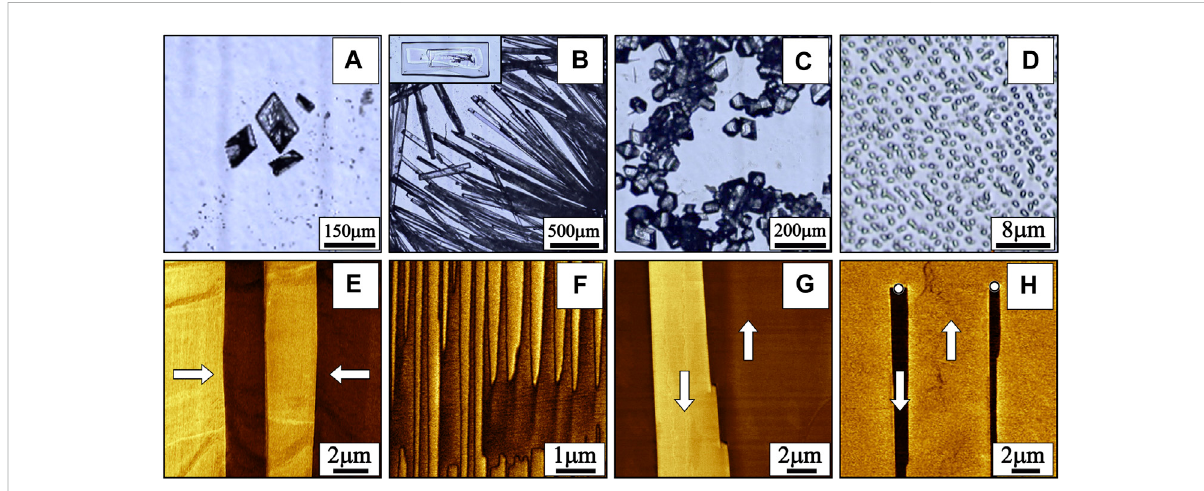
FIGURE 1 Morphology of the glycine microcrystals of different polymorphs: (A) α -phase, (B) β -phase, (C) γ -phase, and (D) microislands of β -glycine. The inset in (B) shows another common morphology of β -glycine crystals well suitable for studies of ferroelectricity. Types of as-grown domains in β - glycine (Vasileva et al., 2019): (E) stripe domains with charged domain walls, (F) quasi-periodic ensembles of needle-like domains, and (G) irregular shaped domains with segmental step-like domain walls. White arrows show the direction of spontaneous polarization. (H) Arti fi cial domains created by the application of an external electric fi eld to the PFM